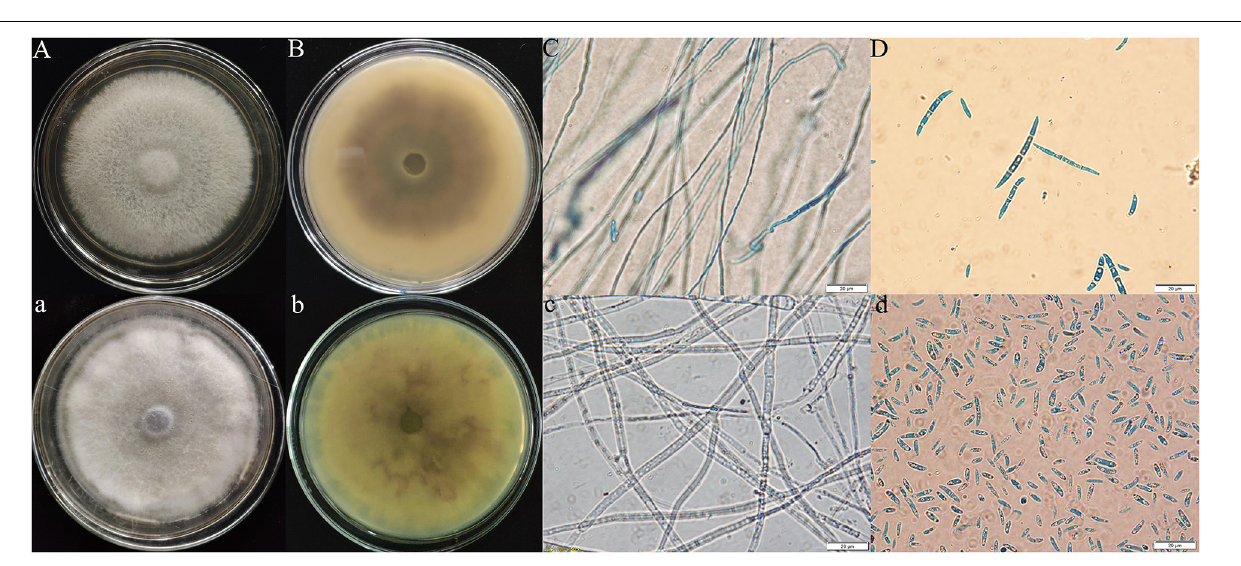
FIGURE 2 | Morphological characteristics of Fritillaria pathogens (Y-5: A–D ; Y-11: a–d ; A,B,a,b : colony morphology; C,D,c,d : microscopic